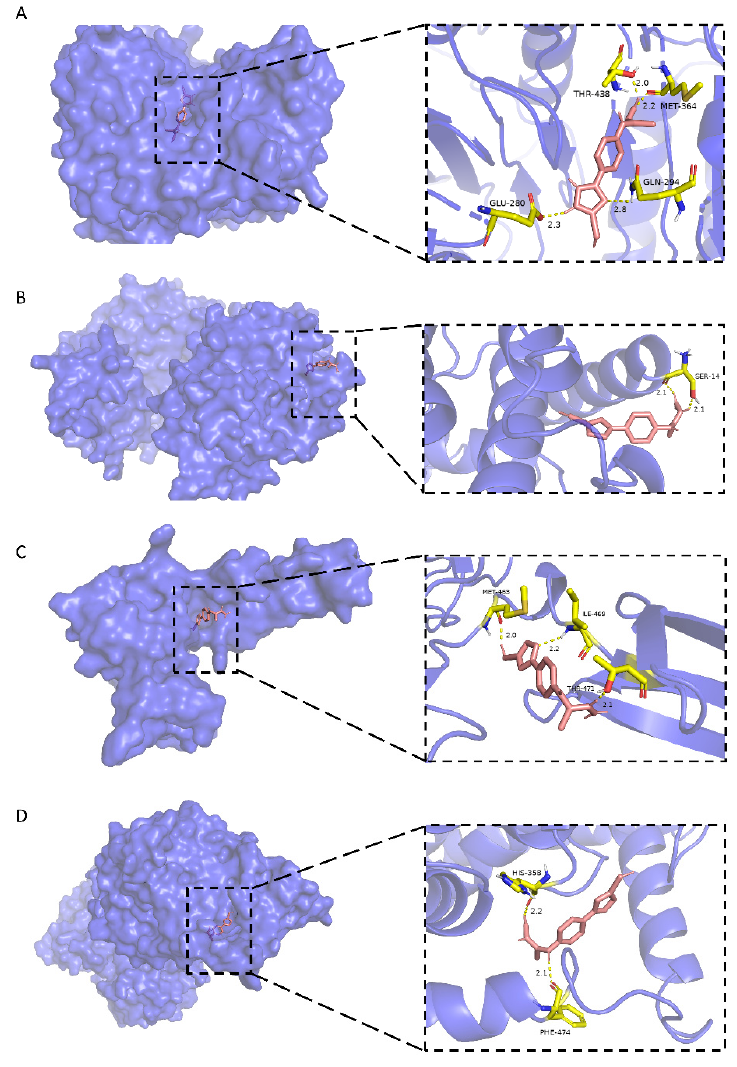
Figure 6. Molecular docking models of stemazole binding to ( A ) CASP2, ( B ) PRKACA, ( C ) FN1 and ( D ) SLC7A5, which are shown as 3D diagrams. ( D ) SLC7A5, which are shown as 3D